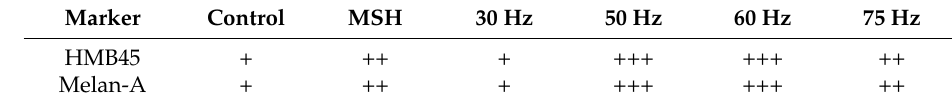
Table 2. Relative staining intensity score for HMB45 and Melan-A.